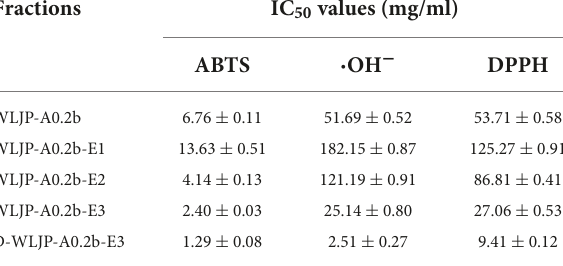
TABLE 2 IC 50 values of different pectins from Lonicera japonica Thunb. toward the scavenging of ABTS, hydroxyl, and DPPH radical.